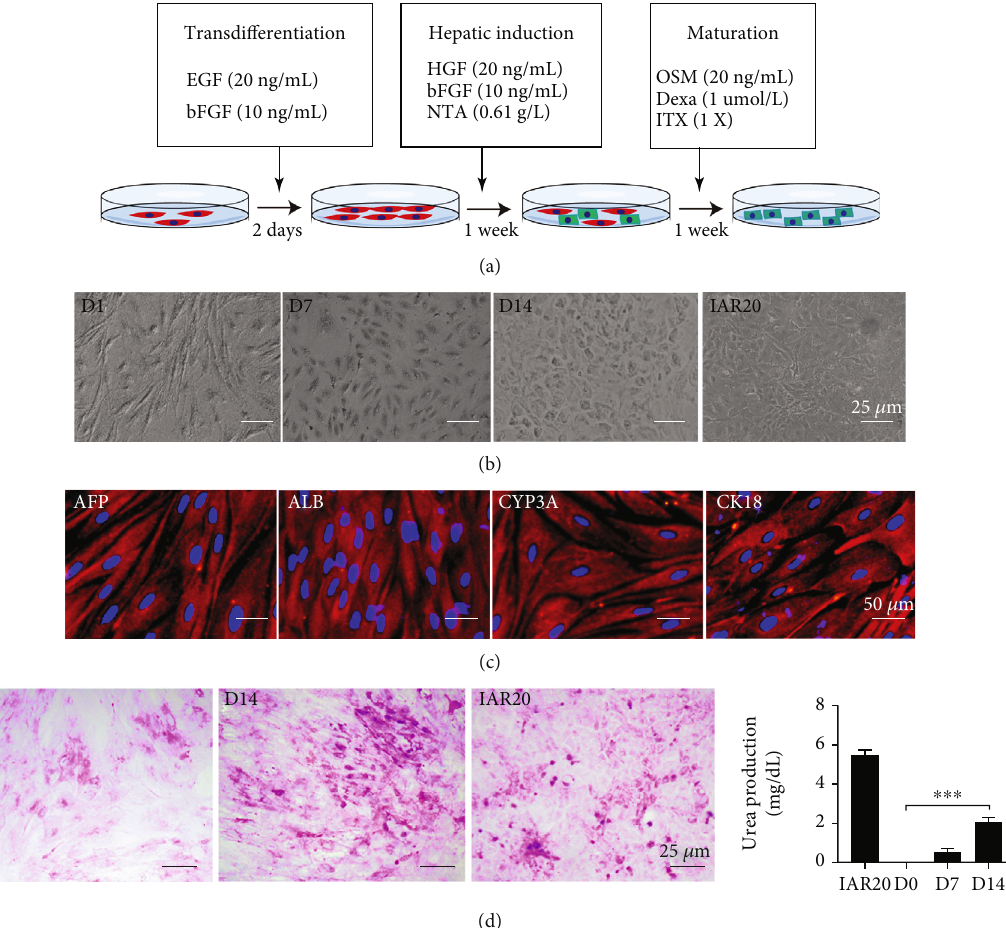
Figure 7: Induction EMSCs into HLCs in vitro. (a) Schematic diagram of EMCSs ’ di ff erentiation into HLCs. (b) Morphological changes of undi ff erentiated EMSCs to di ff erentiated hepatocyte-like cells under hepatogenic conditions. (c) Fluorescent images of hepatic markers of AFP, ALB, CYP3A, and CK18. (d) PAS staining and urea production of di ff erentiated hepatocyte-like